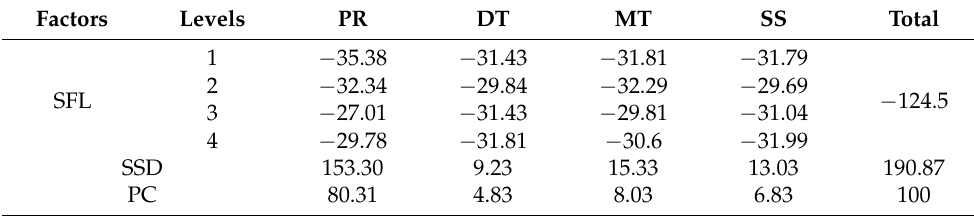
Table 4. Results of Pareto ANOVA for Wear rate (S/N